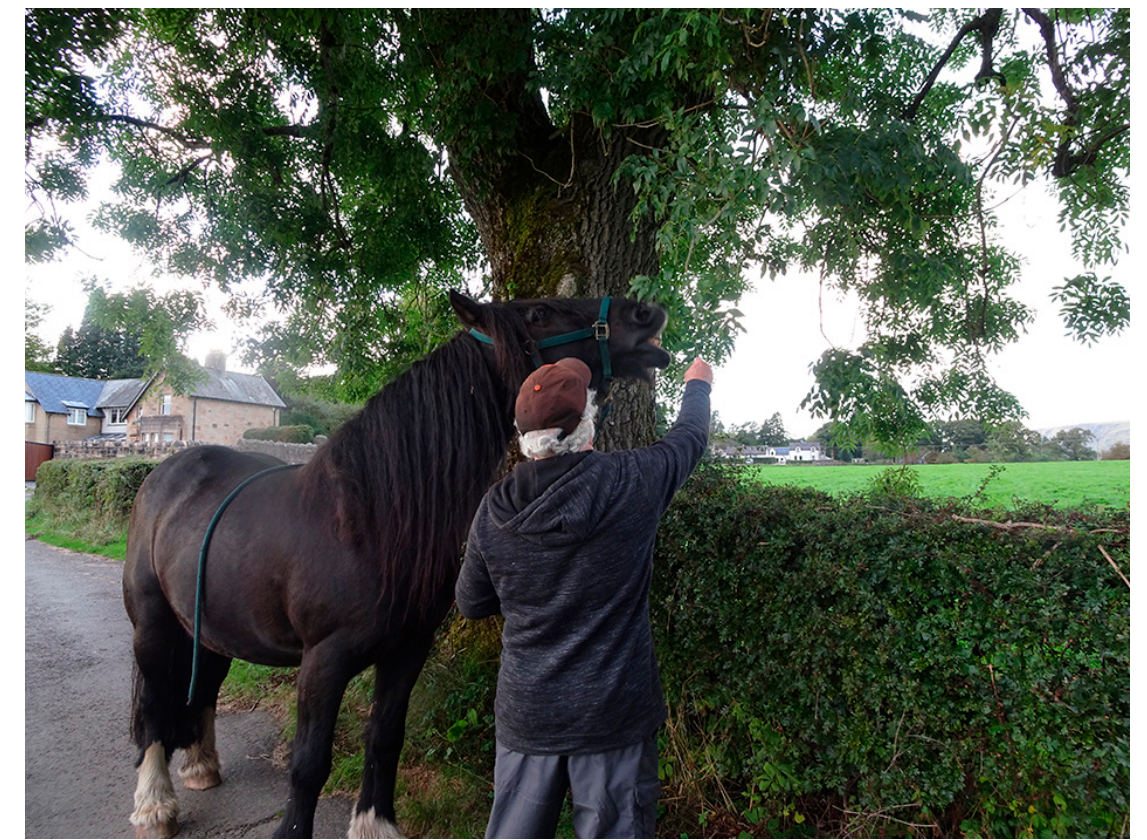
Figure 5. Tim Collins and Darkness at an ash tree. (Collins & Goto Studio 2021).